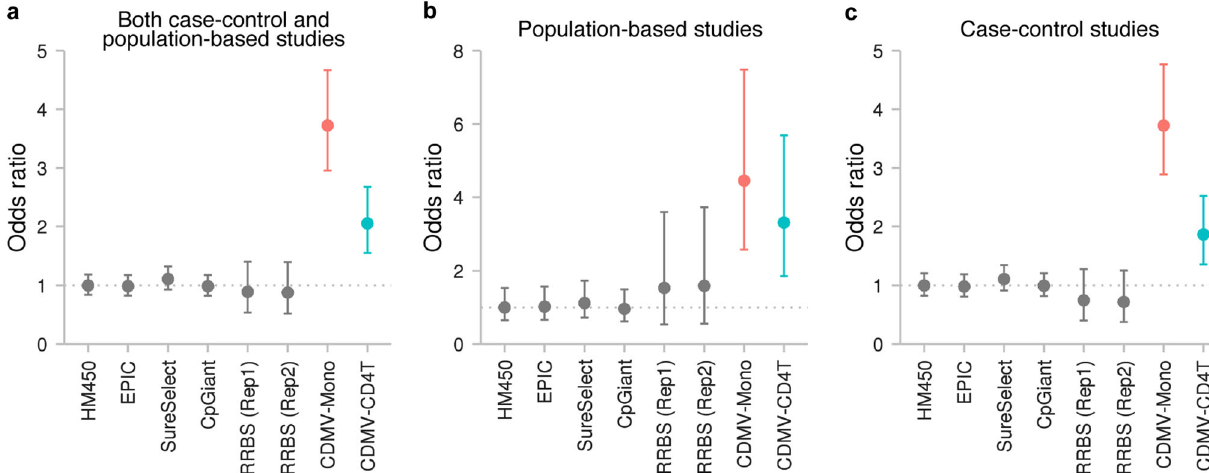
Fig. 7 Improved ef fi cacy of the CDMV strategy. ORs for existing designs of target CpG sites are shown as well as ORs for the strategy. CDMV- Mono and CDMV-CD4T are sets of target CpG sites determined by using the CDMV strategy from our comprehensive DNAm pro fi les of monocytes and CD4 + T cells, respectively. CDMV-Mono includes 2.0 million CpG sites and CDMV-CD4T is composed of 3.0 million CpG sites. The OR was estimated by comparing the biomarker likelihood of each set of target CpG sites with that of CpG sites probed by HM450. The 95% CIs are represented as solid lines . a ORs for population-based and case-control EWASs. The ORs were estimated based on 269 CpG sites previously identi fi ed in population-based and/or case-control EWASs. b ORs for population-based EWASs. The ORs were estimated based on 47 CpG sites previously identi fi ed in population-based EWASs. c ORs for case-control EWASs. The ORs were estimated based on 225 CpG sites previously identi fi ed in case-control EWASs. CpGiant SeqCap Epi CpGiant, HM450 HumanMethylation450, Rep replication, RRBS reduced- representation bisul fi te sequencing, SureSelect SureSelect Human